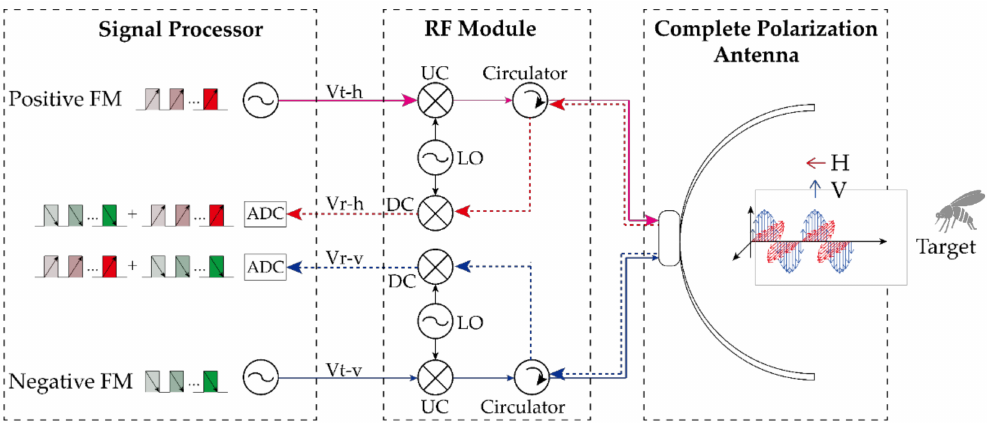
Figure 1. Block diagram of a fully polarimetric entomological radar system. The abbreviations in the figure are as follows: FM, frequency modulation; RF, radio frequency; ADC, analog-to-digital converter; LO, radio frequency; DC,